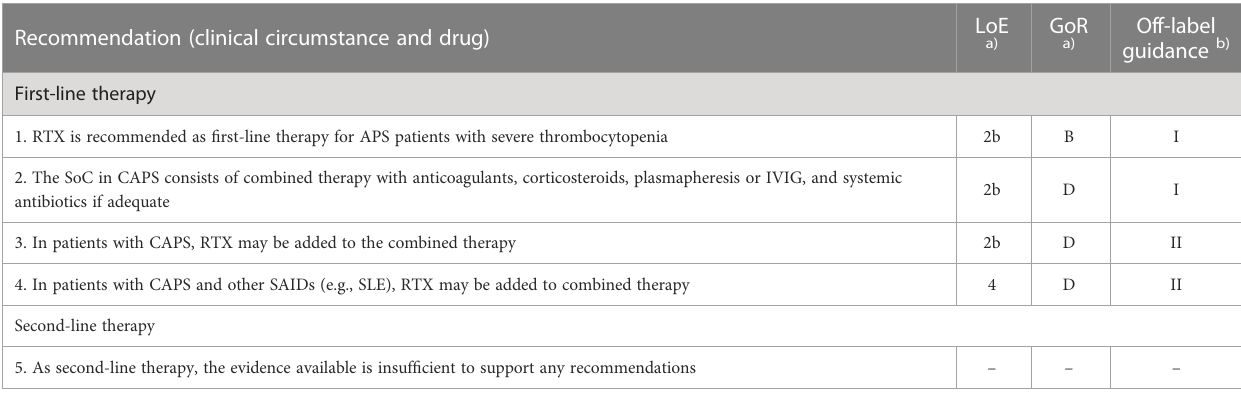
TABLE 3 Recommendations for off-label biologic therapy of antiphospholipid syndrome.